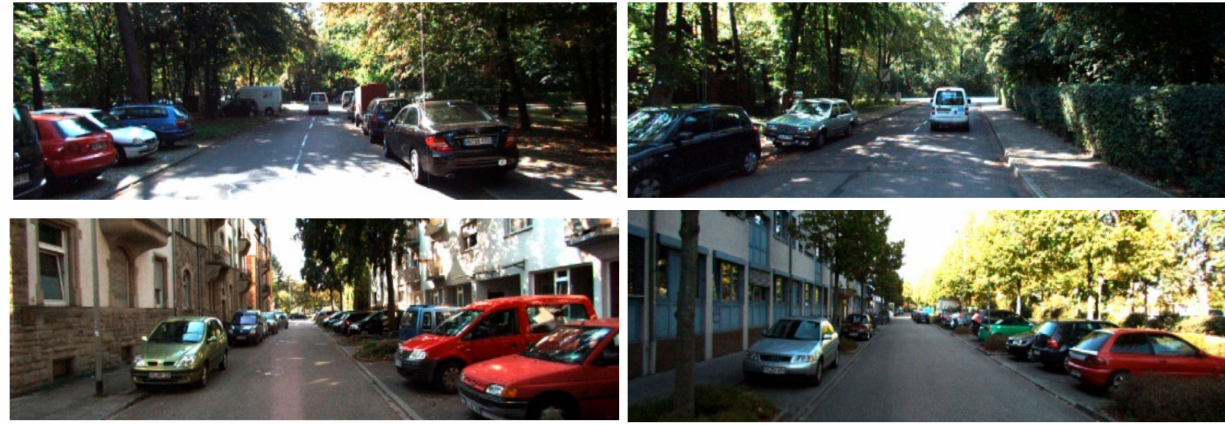
Figure 10. The example images of KTTI